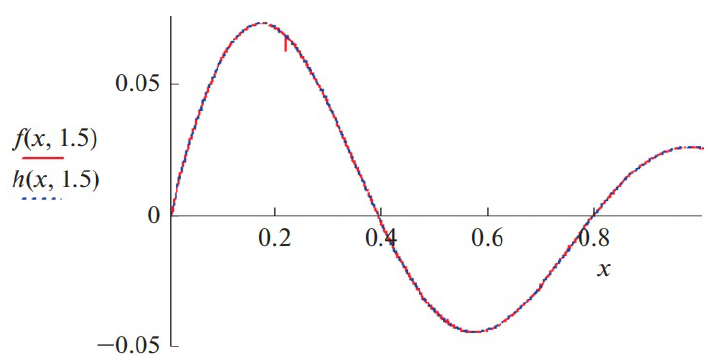
Figure 3. Determination of function by formula (39) in Mathcad and comparison of this function with solution obtained using Laplace transform.